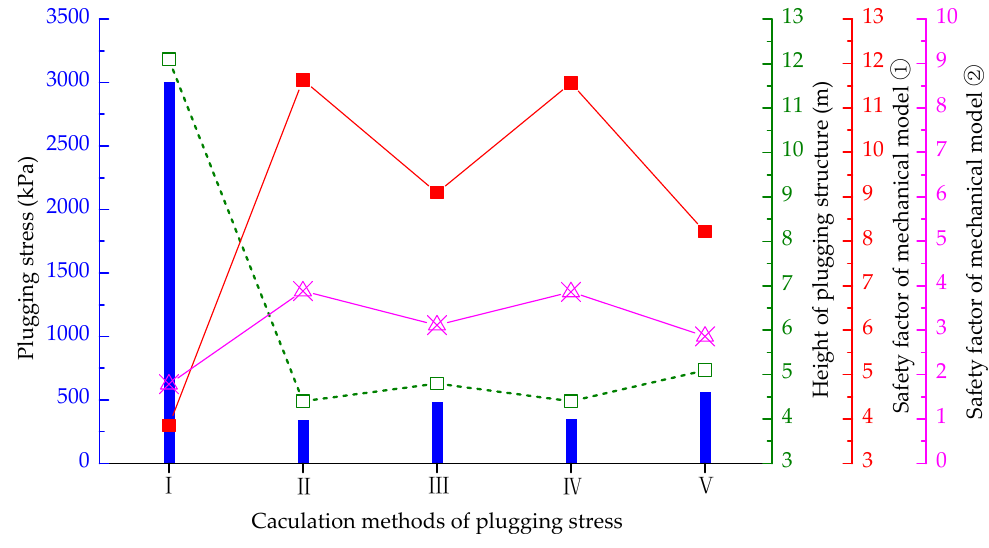
Figure 11. The design heights and safety factors of the plugging structure corresponding to different calculation methods of vertical stress.